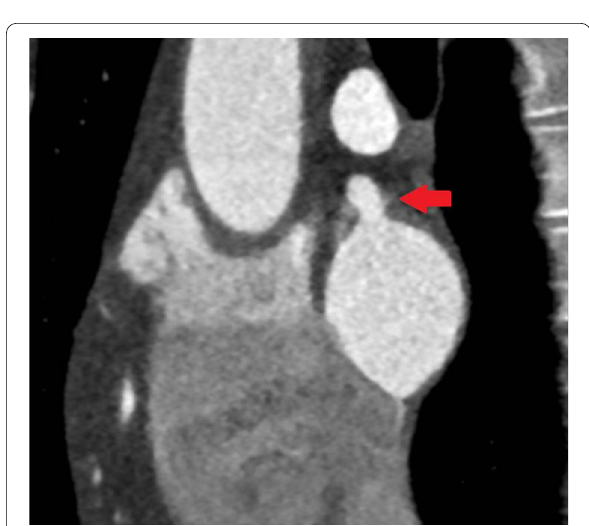
Fig. 2 Tubular diverticulum (red arrow) is observed in the superior localization of the left atrium